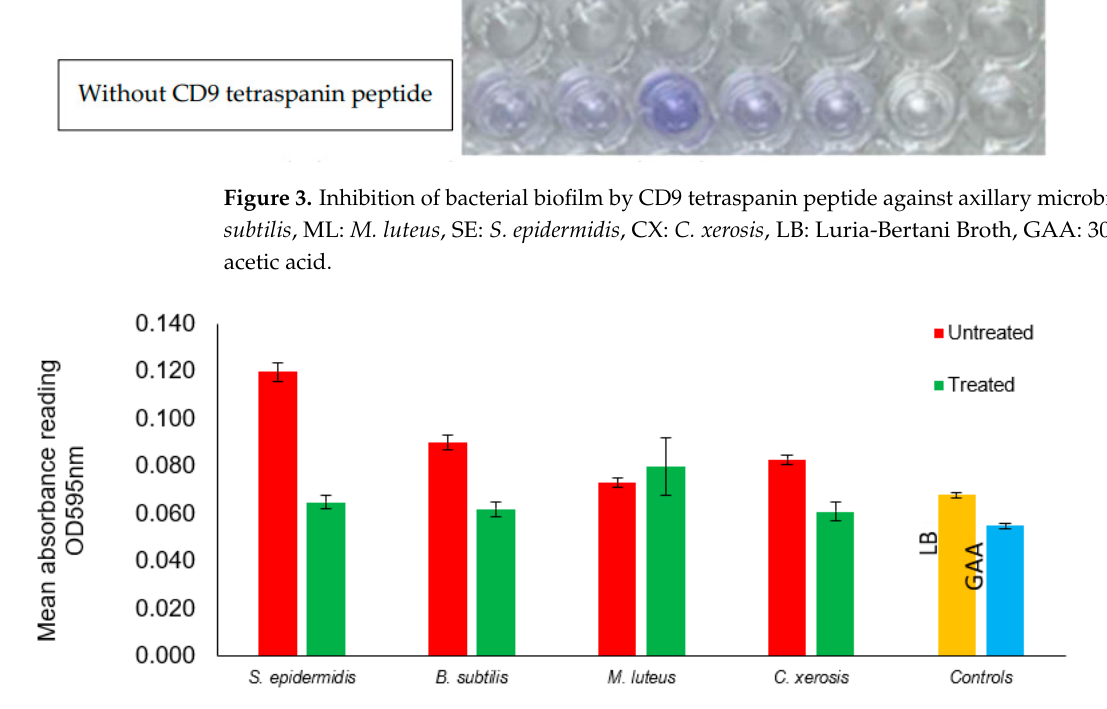
Figure 4. Bar graphs show inhibition of axillary microbiota biofilm by CD9 tetraspanin peptides against axillary microbiota.